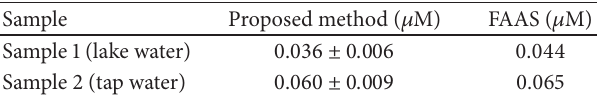
Table 1: Determination of Fe 3+ in lake water and tap water with the proposed method.